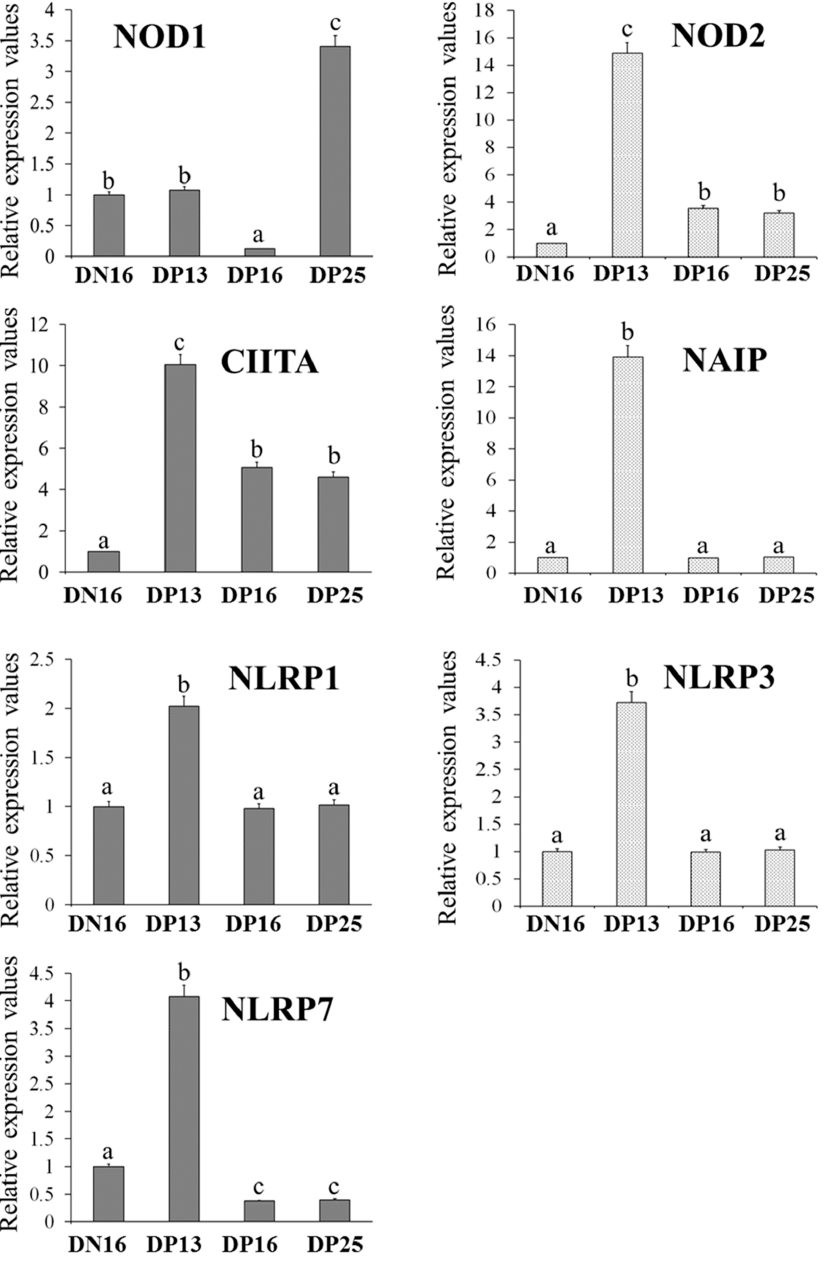
Figure 1. Relative expression values of NOD1, NOD2, CIITA, NAIP, NLRP1, NLRP3 and NLRP7 mRNA in ovine thymus measured by quantitative real-time PCR. Note: DN16 = day 16 of the estrous cycle; DP13 = day 13 of pregnancy; DP16 = day 16 of pregnancy; DP25 = day 25 of pregnancy. Significant differences ( p < 0.05) are indicated by different letters within same color column.